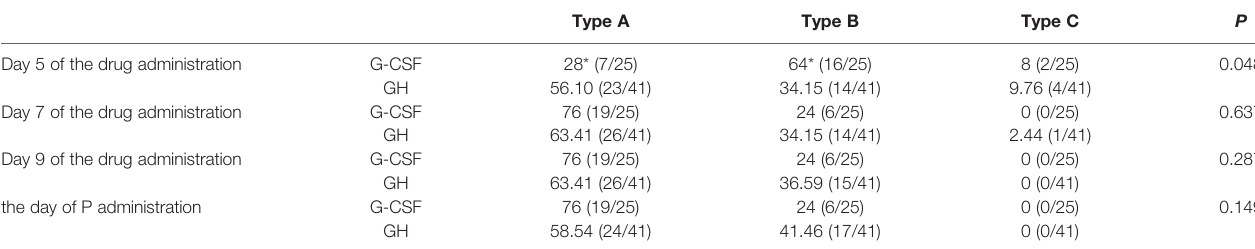
TABLE 4 | Comparison of endometrial morphology between the two groups.